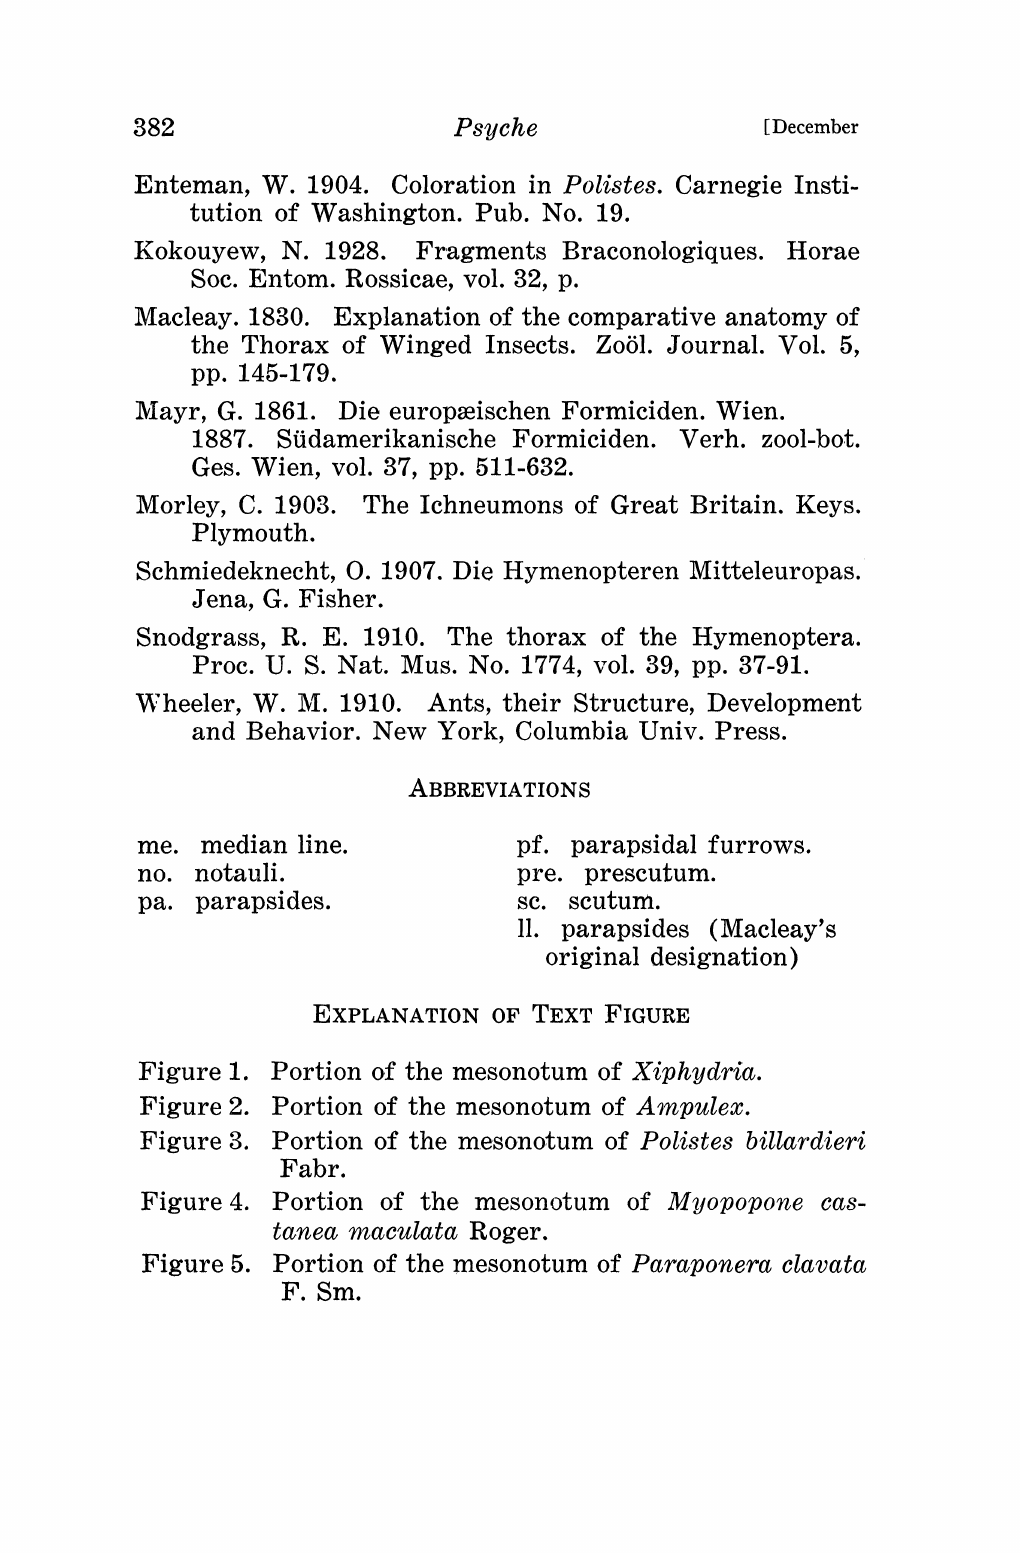
Portion of the mesonotum of Xiphydria. Portion of the mesonotum of Anpulex. Portion of the mesonotum of Polistes billardieri Fabr. Portion of the, mesonotum of Myopopone cas- tanea maculata Roger. Portion of the mesonotum of Paraponera clavata F.